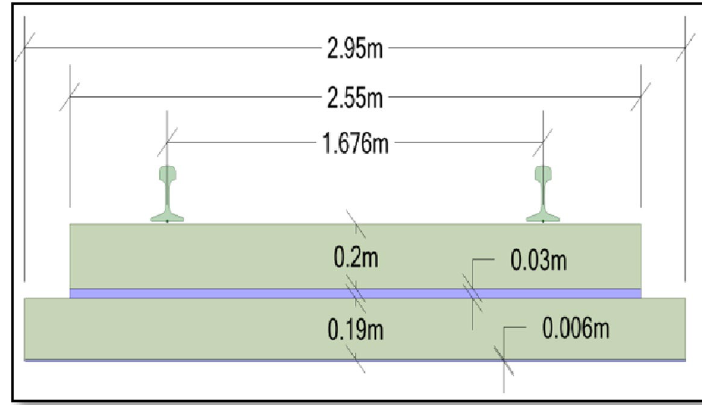
Fig. 6 Sub-Track system cross-section